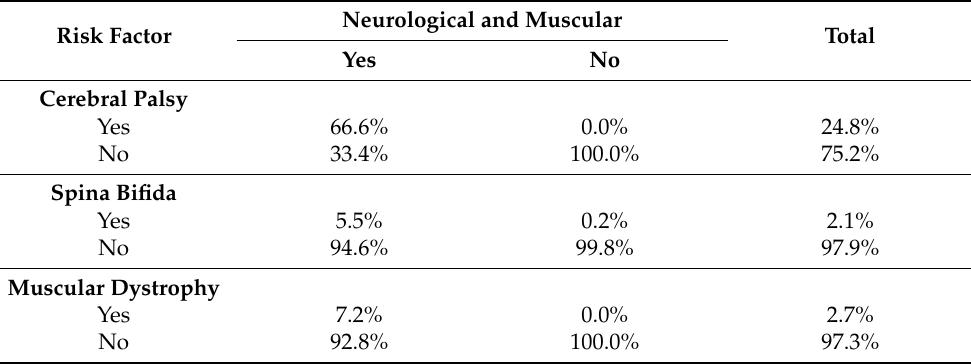
Table 2. Percentage of patients with the neurological and neuromuscular flag who had cerebral palsy, spina bifida, or muscular